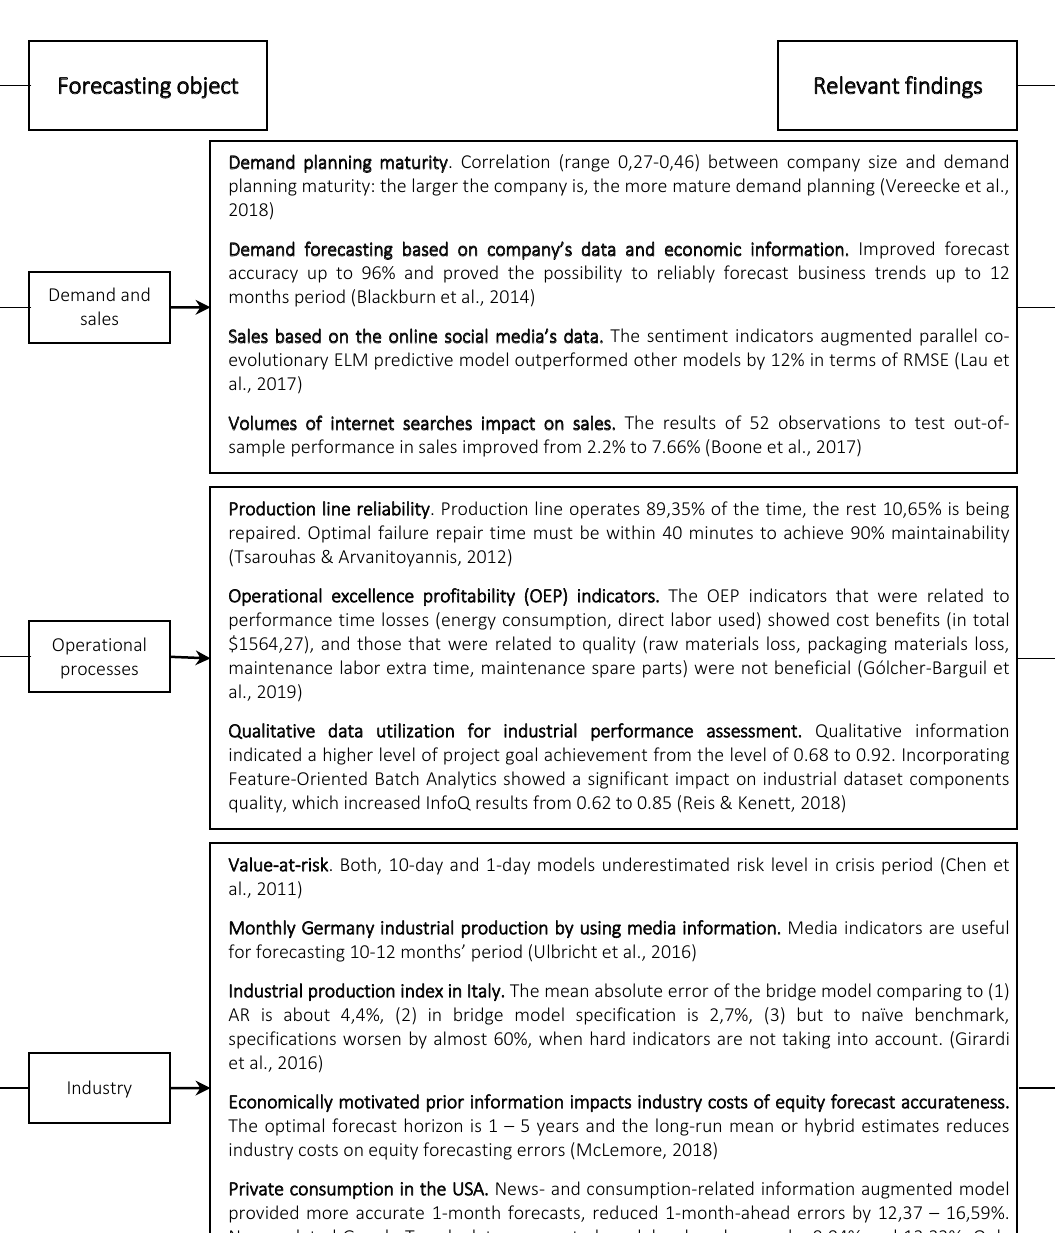
Figure A1. The most relevant literature analysis